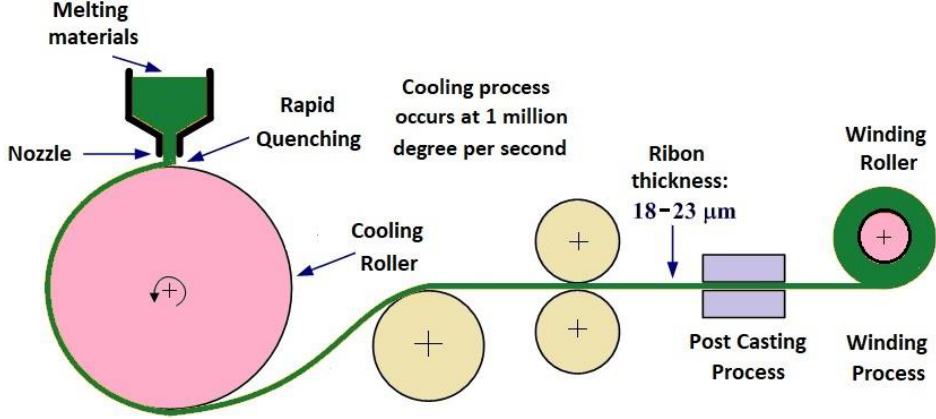
Figure 1. Rapid quenching method for obtaining amorphous/nanocrystalline ribbon materials.